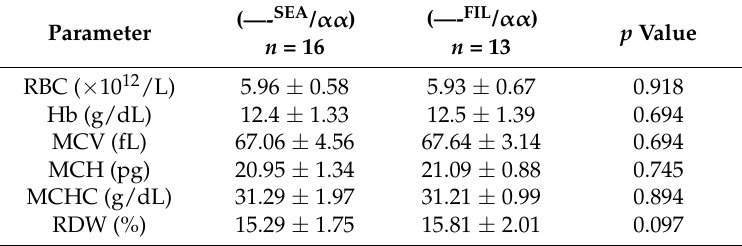
Table 6. Hematologic parameters of (—- SEA / αα ) and (—- FIL / αα ). Data represent mean ± SD (standard deviation). p values less than 0.05 were considered statistically